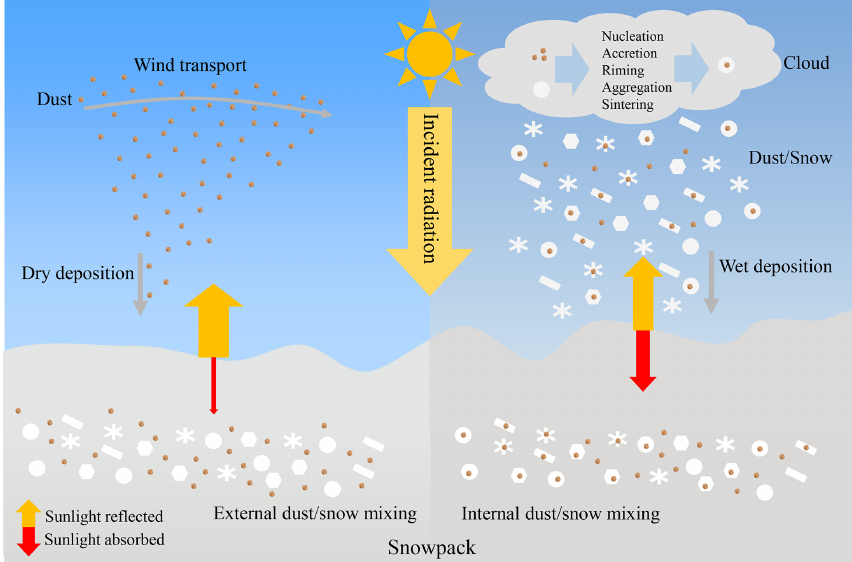
Figure 1. Schematic of dust mixing with snow grains internally. Dust tends to mix externally with snow grains through dry deposition and/or below-cloud scavenging, while dust–snow internal mixtures can be produced by nucleation, accretion, riming, aggregation, and sintering during aerosol–cloud–precipitation processes known as wet deposition. Arrows represent how the absorption (red) and reflection (yellow) of incoming sunlight changes with dust–snow mixing state.